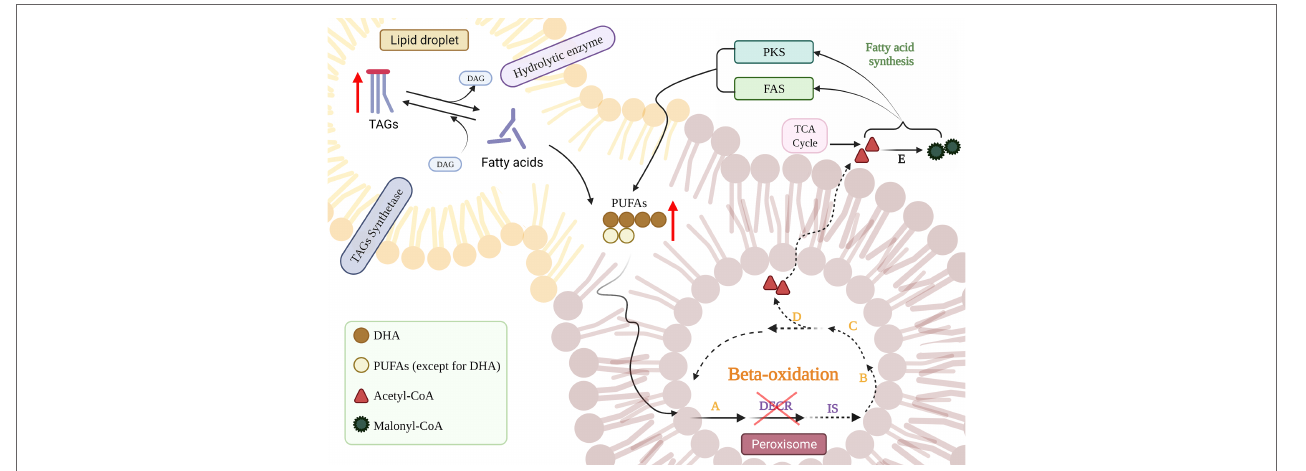
FIGURE 6 | The effect of DECR disruption on the accumulation of PUFAs. The blue downward arrow implies that DECR was knocked down. Red upward arrows indicate increased product accumulation and interrupted lines indicate diminished responses. The orange letters refer to enzymes involved in standard beta-oxidation: acetyl-CoA dehydrogenase (A) , enoyl-CoA hydratase (B) , hydroxyacyl-CoA dehydrogenase (C) , and beta-ketothiolase (D) , respectively. DECR, 2,4-dienoyl-CoA reductase; IS, delta-3,5-delta-2,4-dienoyl-CoA isomerase; DAG, diacylglycerol; TAG, triacylglycerol; PKS, polyketide synthase; FAS, fatty acid synthase; TCA, tricarboxylic acid. Created with